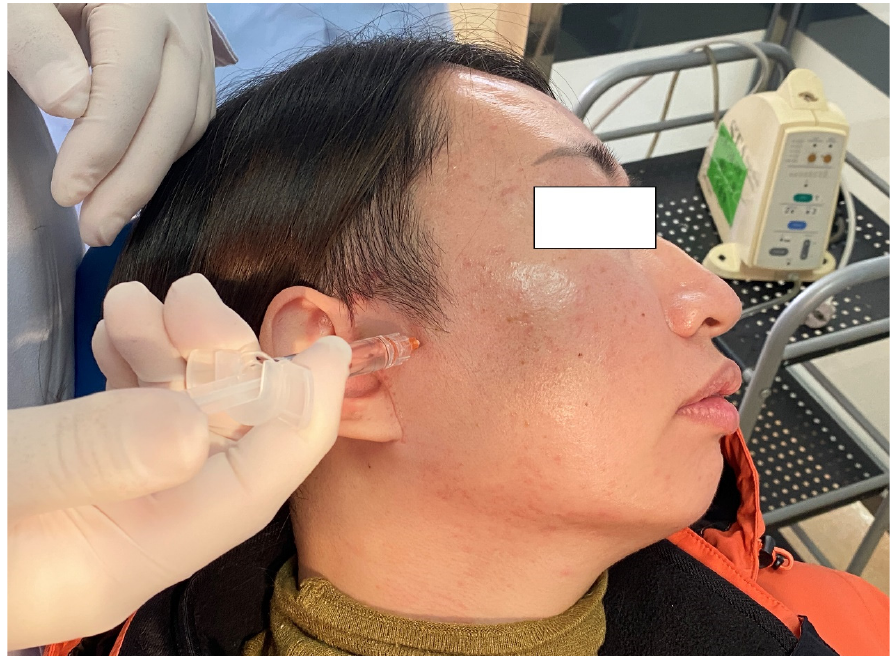
Figure 4. Chitosan injection was